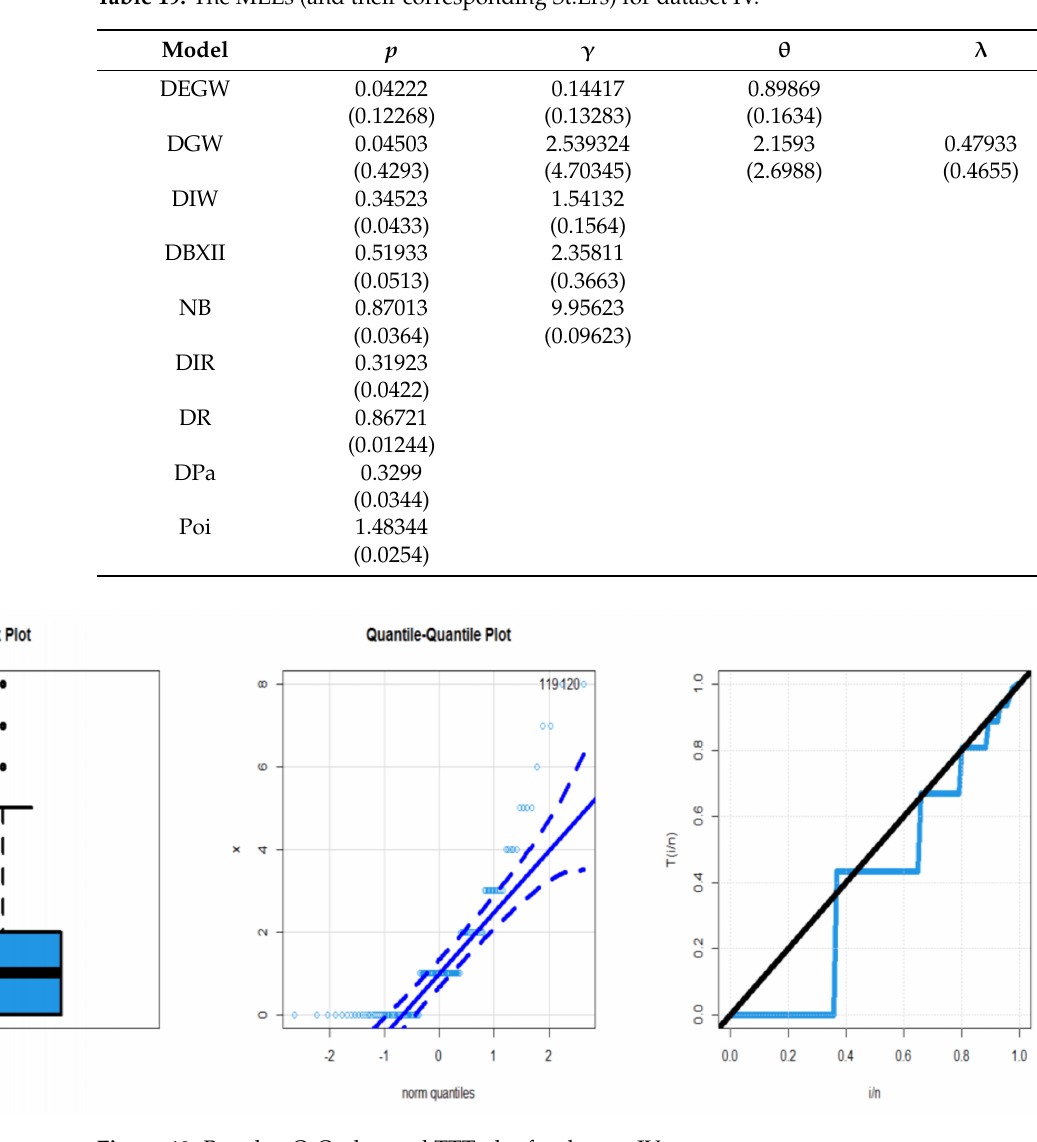
Figure 13. Boxplot, Q-Q plot, and TTT plot for dataset